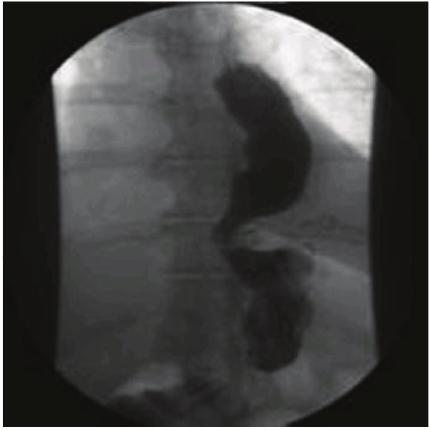
Figure 3: Pouch dilatation following sleeve